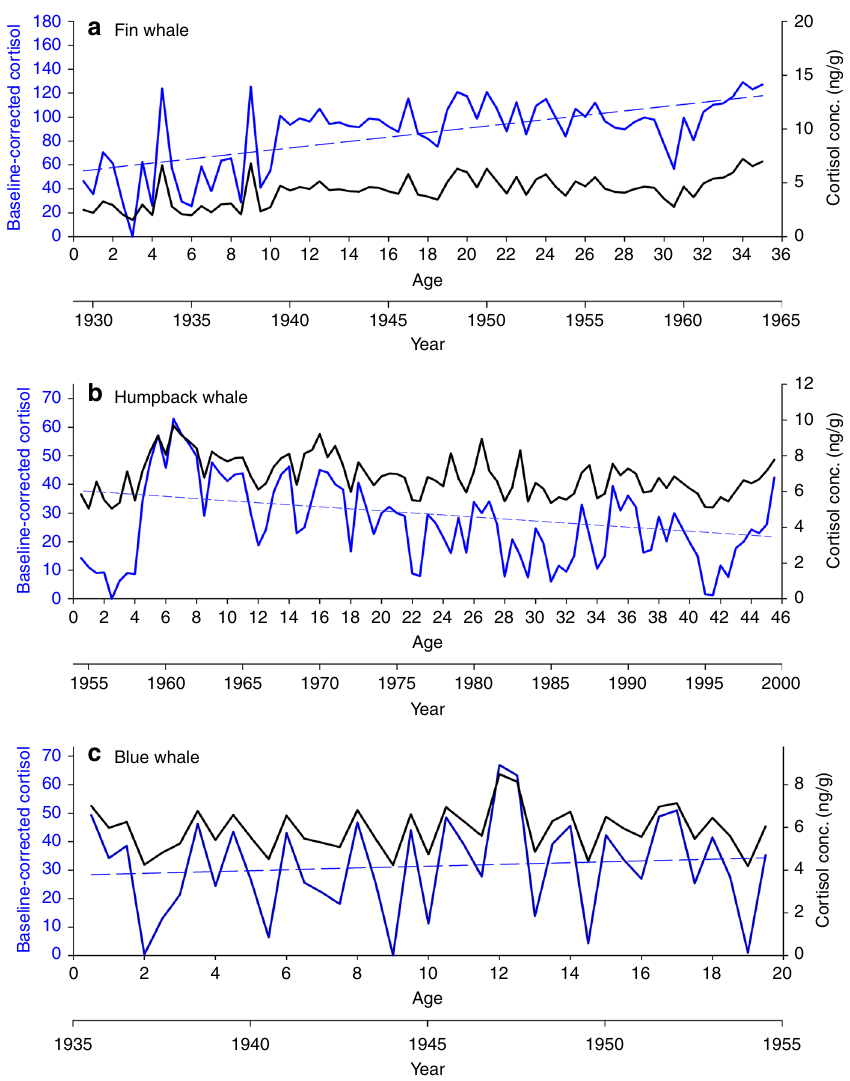
Fig. 2 Baseline-corrected cortisol as a function of age and year. Reconstructed lifetime cortisol concentrations (ng/g; black line) and baseline-corrected cortisol (blue line) pro fi les for a a 35-year-old fi n whale with a positive lifetime stress trend (dashed blue line), b 45-year-old humpback whale with a negative lifetime stress trend (dashed blue line), and c 19-year-old blue whale with no lifetime stress trend (dashed blue line)